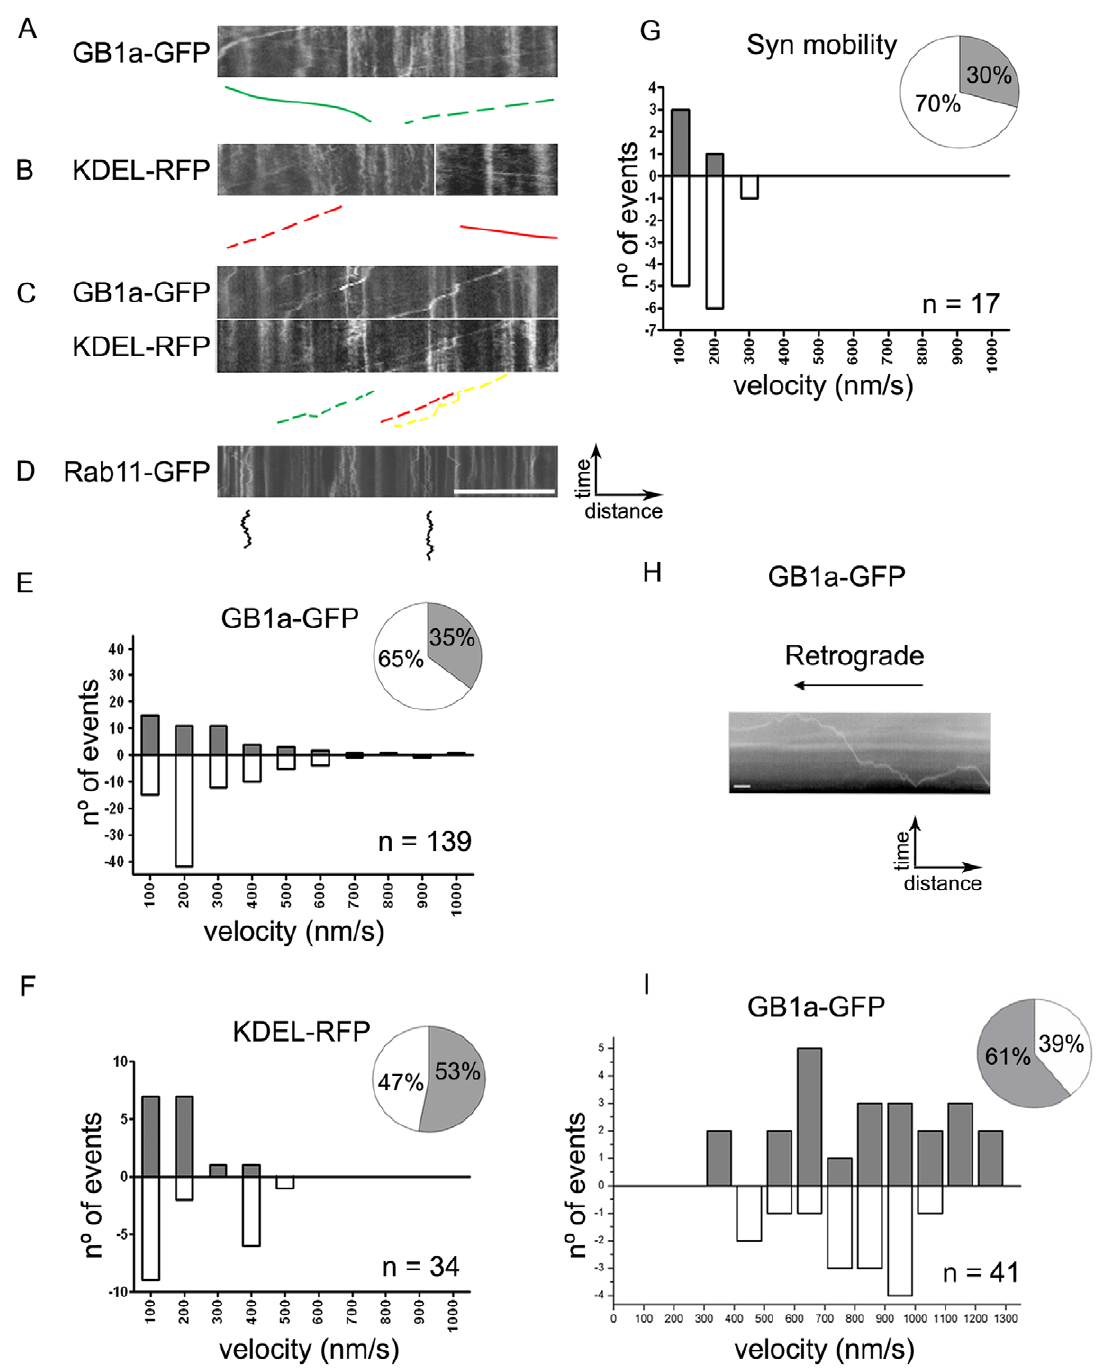
Figure 3. GABA B R1a and KDEL are mobile in axons. ( A ) Representative kymograph constructed from time series of axons of hippocampal neurons transfected with GABA B R1a-EGFP (GB1a-GFP). Color lines correspond to selected traces within the corresponding kymograph. Solid green line: anterograde mobility; dashed green line: retrograde mobility. ( B ) Same as above for KDEL-RFP. Solid red line: anterograde mobility; dashed red line: retrograde mobility. ( C ) Representative kymographs from time series of axons of hippocampal neurons transfected with GABA B R1a-EGFP and KDEL-RFP. Dashed green line: retrograde mobility of GABA B R1a-EGFP; dashed red line: retrograde mobility of KDEL-RFP; dashed yellow line: synchronous retrograde mobility of GABA B R1a-EGFP and KDEL-RFP. ( D ) Representative kymographs constructed from axons of hippocampal neurons transfected with Rab11-GFP. Solid black lines: short-range bidirectional mobility of Rab11-GFP (representative kymograph of n=14 neurons). Images were acquired at 0.20–0.25 frames/s for a total of 120 s. Scale bar for A–D represents 20 m m. ( E–G ) Average velocity and directionality was quantified from the kymographs for GABA B R1a-EGFP, KDEL-RFP and synchronous mobility of GABA B R1a-EGFP and KDEL-RFP. Bar graphs represent the frequency distribution of velocities, anterograde transport (gray bars), retrograde transport (white bars). Pie charts represent fractions of anterograde (gray) and retrograde transport (white). Average velocities and direction were obtained from 17–139 moving puncta from a total of 42 neurons from at least three independent culture preparations. ( H ) Representative kymograph from time series of axons of hippocampal neurons transfected with GABA B R1a-EGFP imaged by TIRF microscopy at 2 frames/s. Scale bars represent 10 s and 3 m m. ( I ) Bar graph represents the frequency distribution of